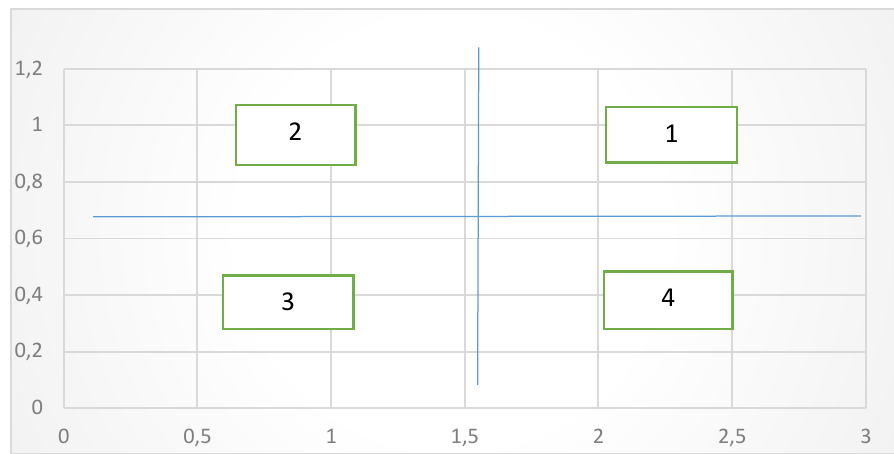
Figure 1. Izard's model in urban-regional